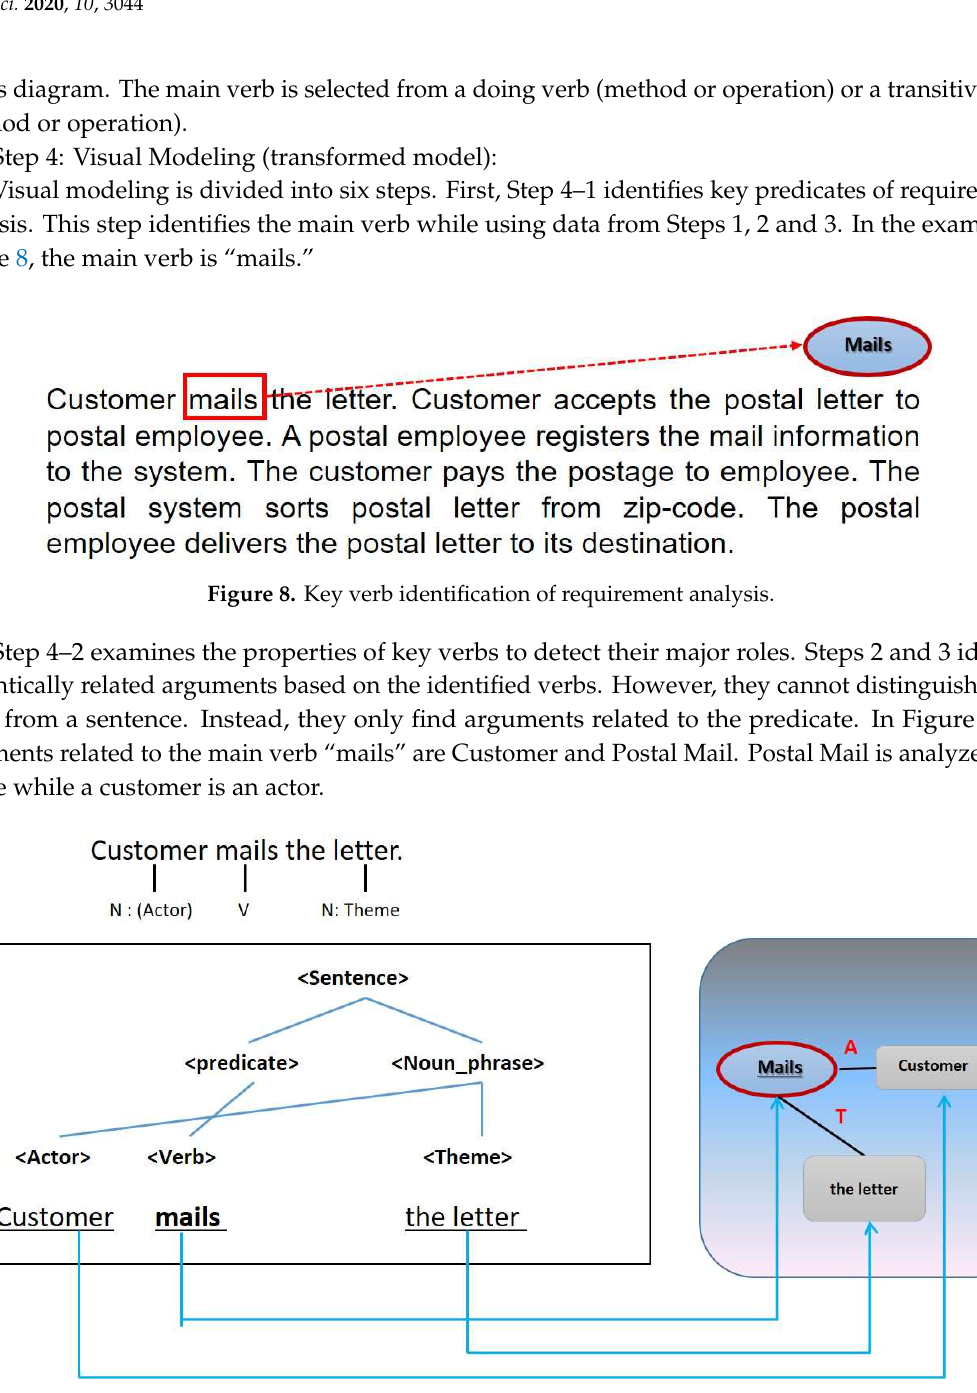
Figure 9. Assignment of argument’s role.